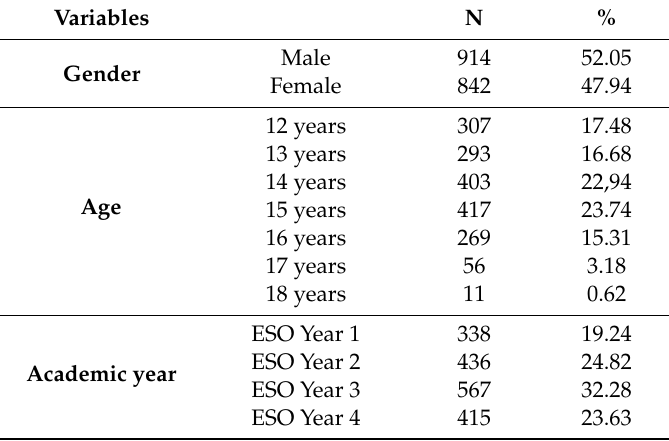
Table 1. Results by students’ gender, age, and academic